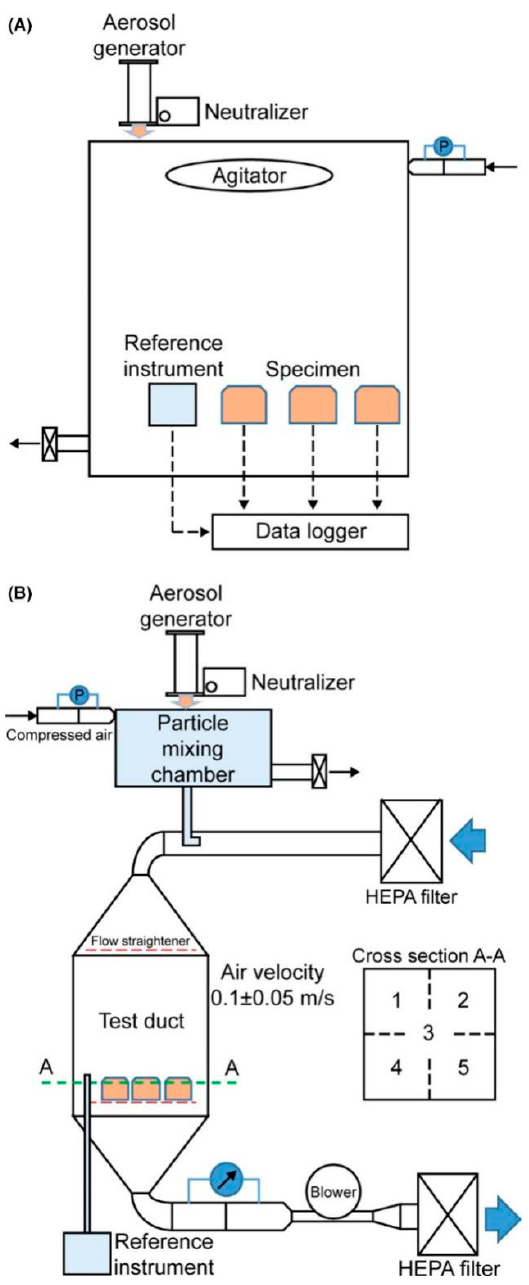
Figure 12. Schematics of low-cost dust sensor evaluation systems: ( A ) chamber test; ( B ) low-speed duct test (image reprinted under the terms of the Creative Commons Attribution 4.0 License (CC BY 4.0); Indoor air, 30(1), 137–146, doi:10.1111/ina.12615).